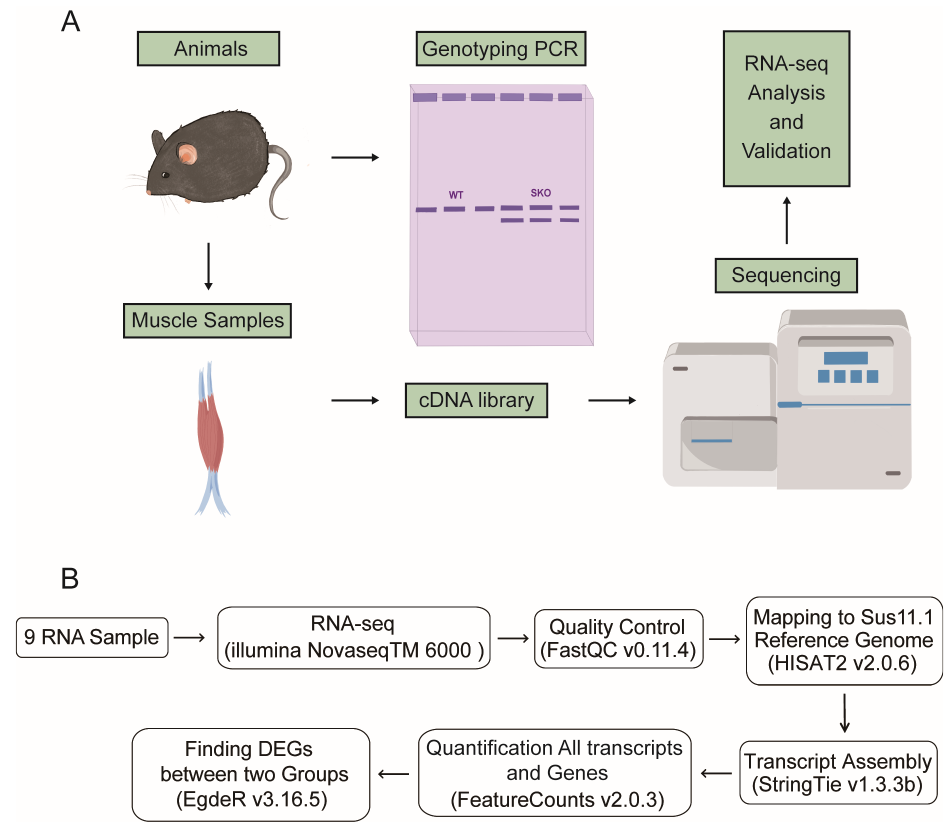
Figure 4. Schematic diagram of technical route. ( A ) The sample processing process includes two parts: the first part is genotyping, and the second part is muscle tissue RNA extraction, library construction, and sequencing. ( B ) Flowchart of RNA-sequencing and transcriptome analysis in this study.